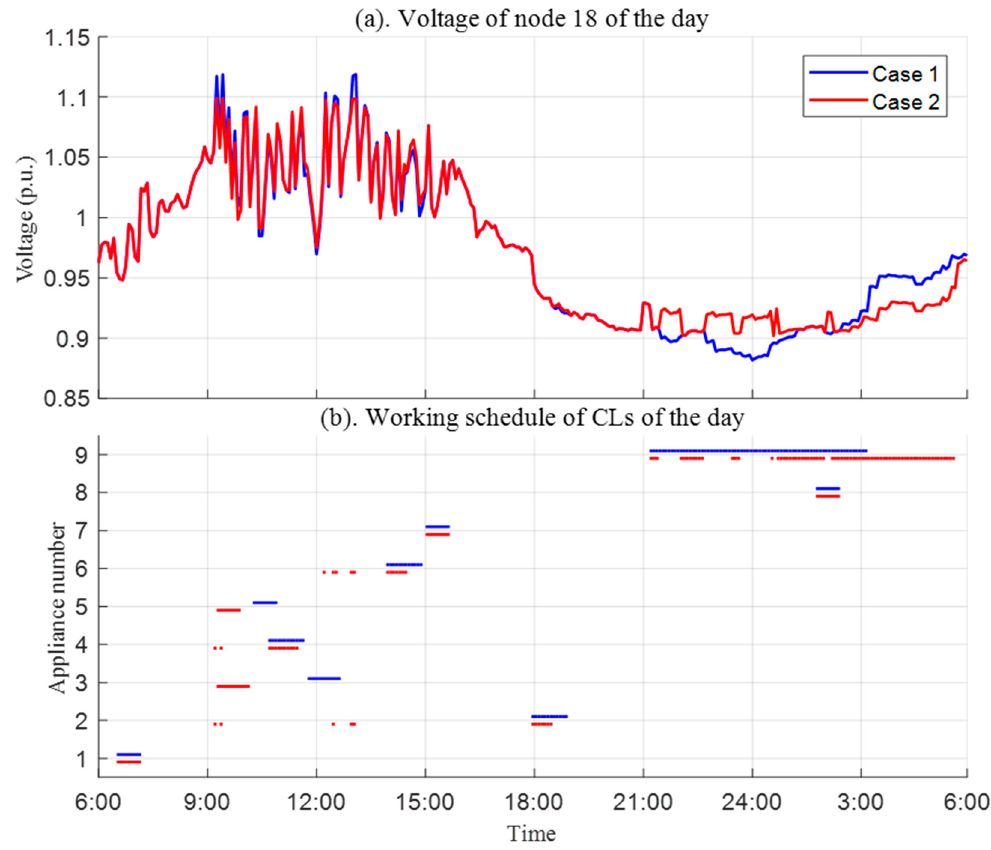
Figure 14. Voltage conditions and CL working schedule of node 18.